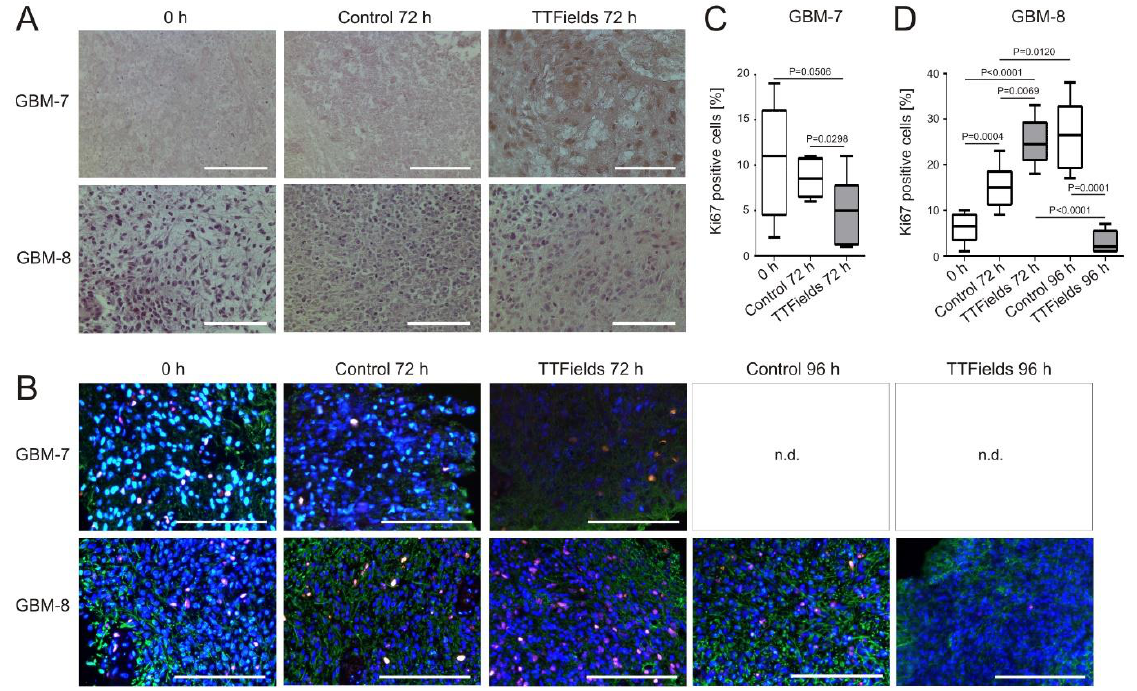
Figure 6. Decreased proliferation of TTFields-treated human organotypic GBM tumor slice cultures. Human GBM were sliced, cultured, treated with TTFields at 200 kHz for the indicated time periods and ( A ) hematoxylin and eosin-stained. ( B ) Immunofluorescence staining of adjacent slices of the same tumors for Ki67 (red), GFAP (green) and with DAPI (blue). Shown are representative images of n = 3. Scale bar = 100 µm. n.d. = not determined. ( C ) Quantification of Ki67 positive cells in slice cultures of GBM-7 and ( D ) GBM-8 after treatment with TTFields at 200 kHz. For clinical details of the patient-derived tumor slices refer to Table 1.